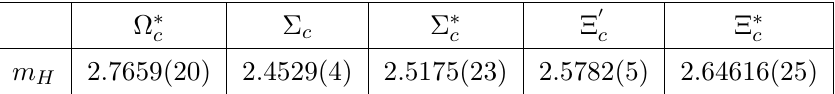
Table 19. Masses, in GeV, of (excited) baryon states relevant for determining the baryon wavefunc- tions in section 5.1 using the representation in eq. (5.14) [141], taken from PDG [21]. Uncertainties in the final digit(s) are neglected in this study, but are given in brackets.